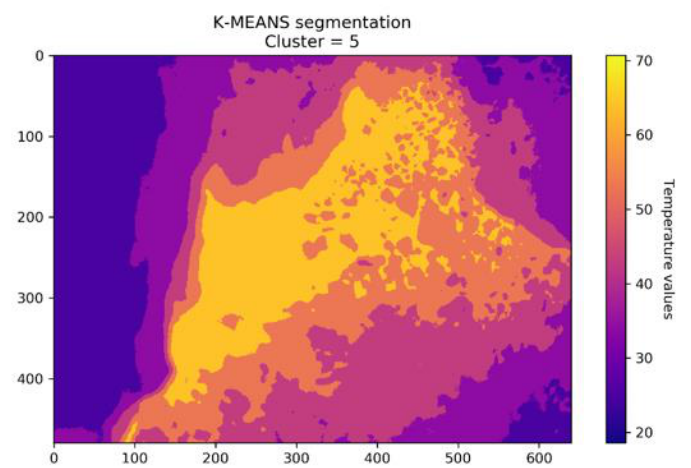
Figure 5. Example of a segmented image through K-MEANS (K = 5); the palette on the right side of the image shows the correlation between colors and temperature. Not all the temperature intervals are shown in the image as each segment is represented using its average temperature. The temperatures are in °C . This image was taken from the Vesuvio area indicated as “SV2” in Figure 1. The default setting is to separate the image into five segments, but the user can over- ride the value of the parameter K. A higher value of K gives a greater precision in segment detection, requesting on the other hand a greater processing time while a lower value will give lower processing time and lower precision. The segmentation phase splits the image into different areas, a sort of “macro -clus- ter” (segments) that needs yet another division process to find even multiple separated hot areas within the hot cluster: the final goal is to achieve clusters that are not linked between them. A second separation is then required to split eventual nonconnected areas that may be present in a segment (Figure 6). Figure 6. Example of the previous segmented image where the hot segment is highlighted: it will then further break up using the DBSCAN algorithm. As for Figure 5, not all the intervals of temper- ature are shown on the image as each segment is represented with its average temperature. Tem- peratures are in °C. The second step entails passing the hot segment detected via image segmentation to a function that applies DBSCAN clustering techniques (Figure 7). DBSCAN works by grouping together a number of “pieces” of a set when some “distance” between them is